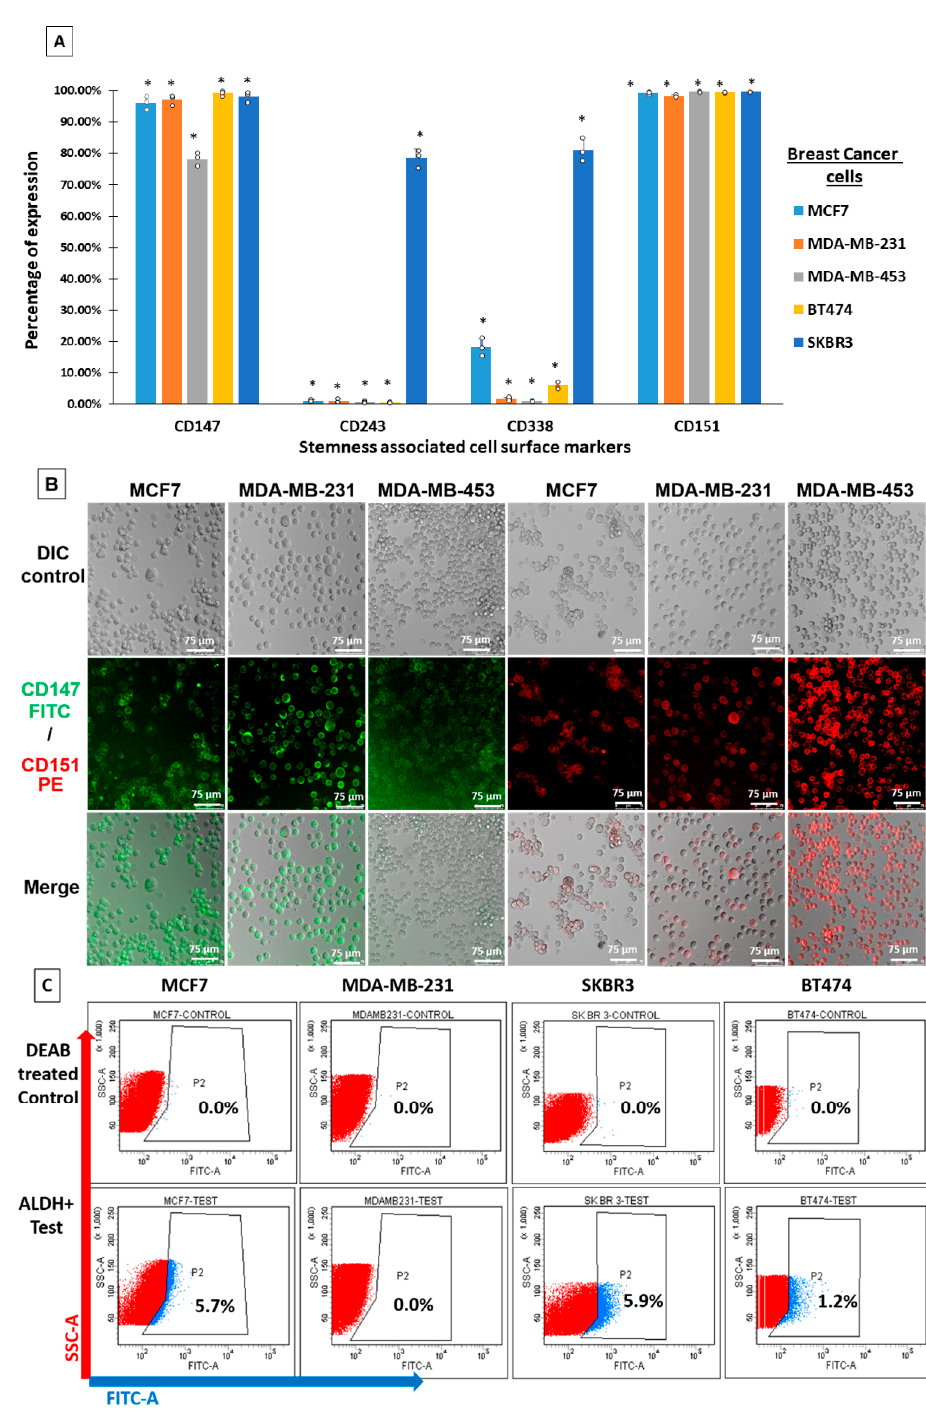
Figure 1. Expression profiling of stemness-associated markers in breast cancer. ( A ) Breast cancer cell lines were screened for the expression of the cell surface marker CD147/Basigin or EMMPRIN, CD151/tetraspanin, and drug transporter proteins CD243/ABCB1 and CD338/ABCG2. More than 5% of MCF7, BT474, and SKBR3 cells expressed drug transporter proteins (* comparison between unstained control and stained cells for each cell line, p ≤ 0.05; calculated by Student’s t -test). ( B ) Immunofluorescence staining for CD147 and CD151 (scale bar measures 75 µm). ( C ) Breast cancer cell lines MCF7, BT474, and SKBR3 showed positive expression for aldehyde dehydrogenase activity (ALDH), indicating the enrichment of cells with higher self-renewal and drug resistance potential.